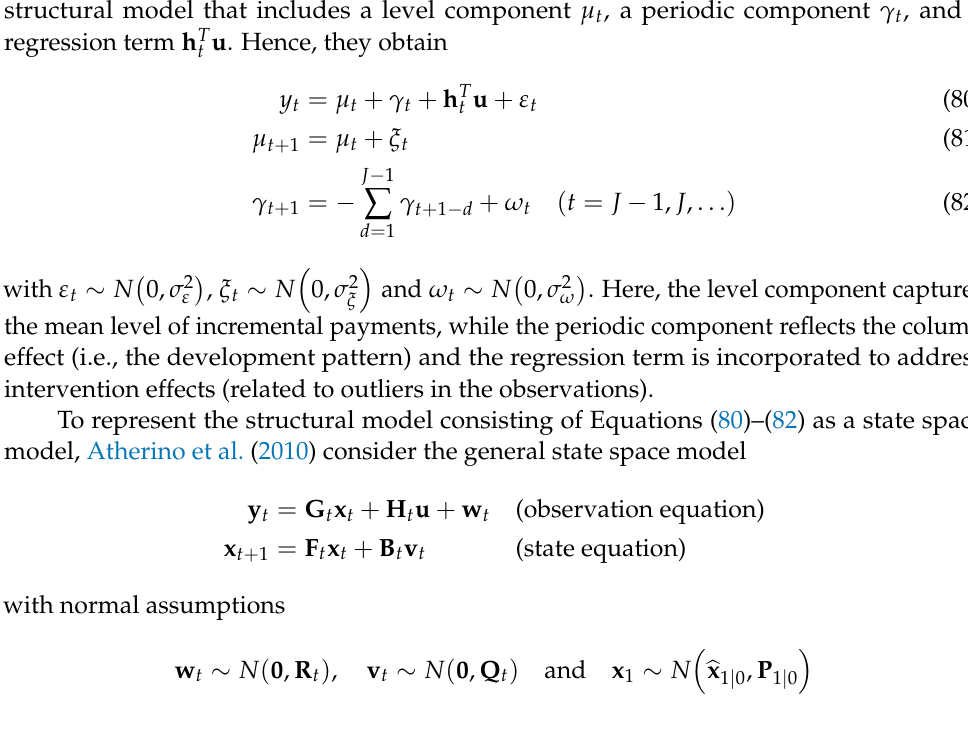
Figure 10. Row-wise stacked incremental payments in the work of Atherino et al. (2010). Atherino et al. (2010) model the row-wise stacked incremental payments y t via